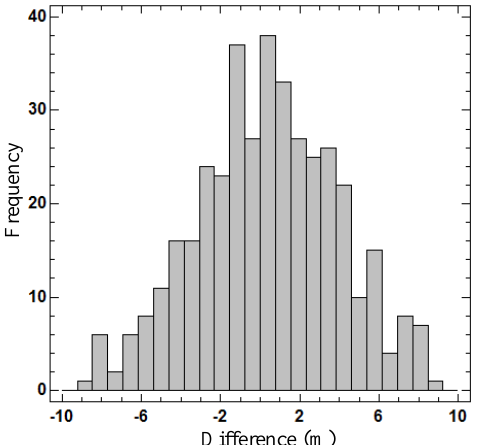
Difference (m) Figure 7. Histogram differences of the average shoreline position along the coast (sector A) defined by both sets of data (high precision and Landsat) and representative of the period 2009-2010.